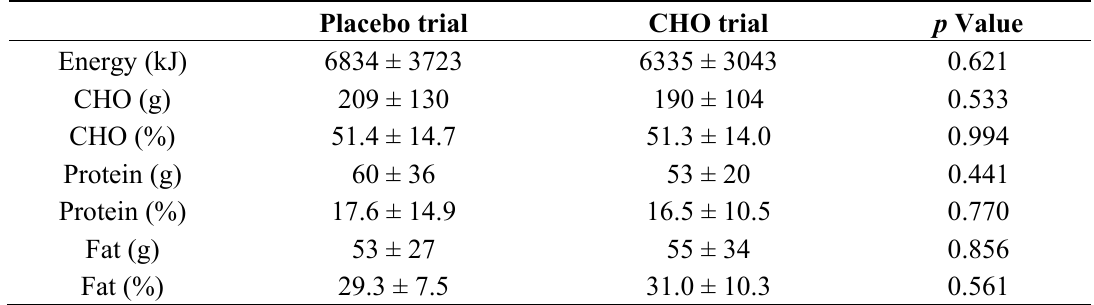
Table 1. Average energy and macronutrient intake 1 day prior to the carbohydrate (CHO) and placebo